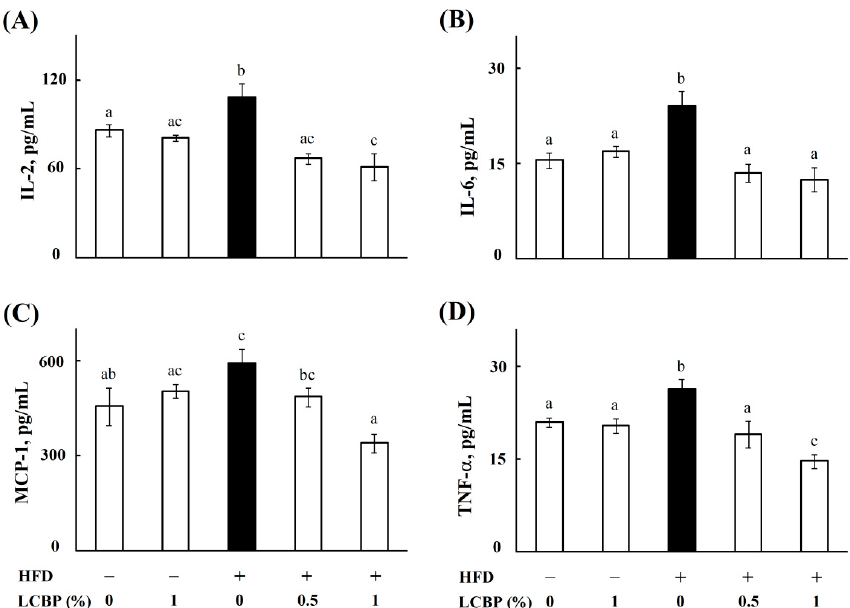
Figure 1. The effect of LCBP on serum levels of cytokine. IL-2 ( A ), IL-6 ( B ), MCP-1 ( C ), and TNF- α ( D ) were measured by using a Bio-Plex Pro Mouse Cytokine 23-Plex Panel kit (Bio-Rad Laboratories, Inc., Hercules, CA, USA). The data represent mean ± SD of four mice. Bars with different letters differ significantly ( p < 0.05). HFD, High fat diet; LCBP, Lonicera caerulea L. berry polyphenols; IL, interleukin; MCP-1, monocytes chemotactic protein-1; TNF- α , tumor necrosis factor-alpha.